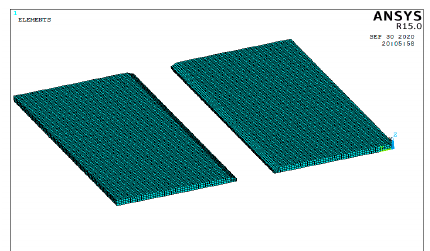
Figure 24. The precast layer model of a composite slab.